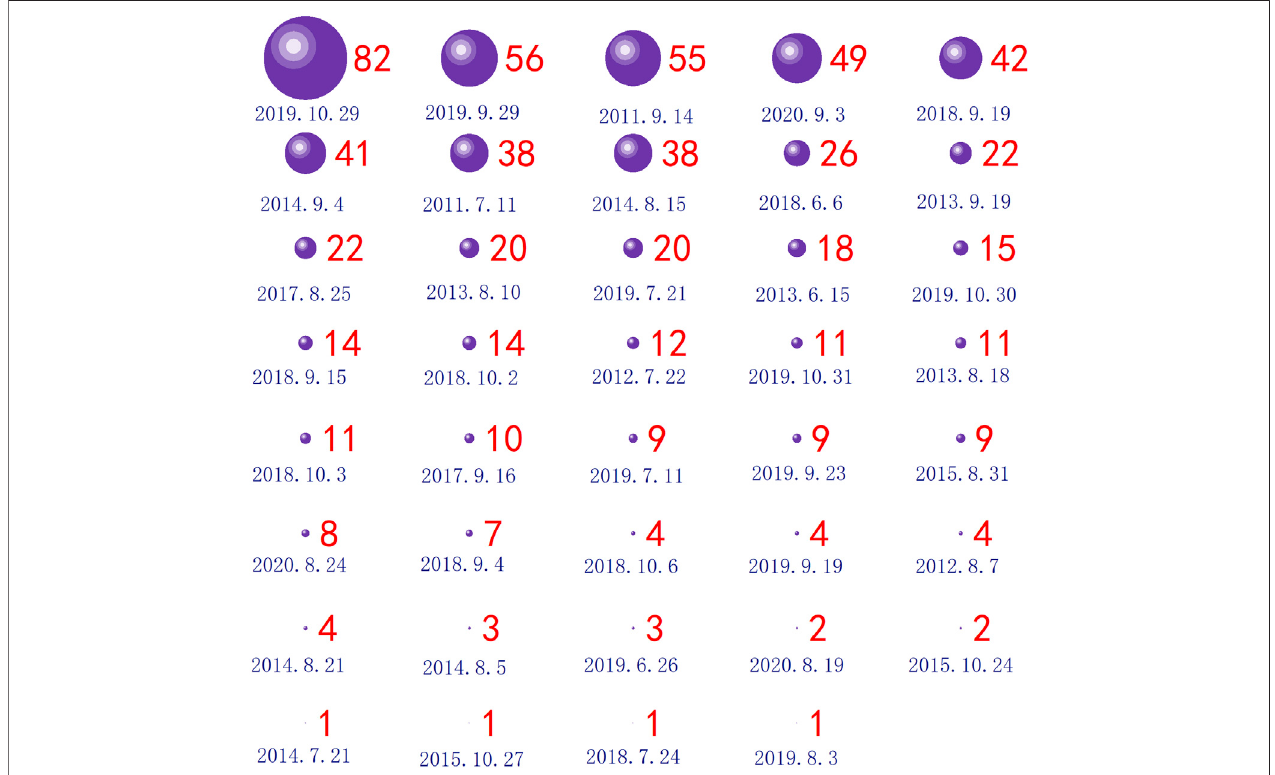
FIGURE 13 | Counts of dates that contribute to unevenness of grid cells with S > 1.